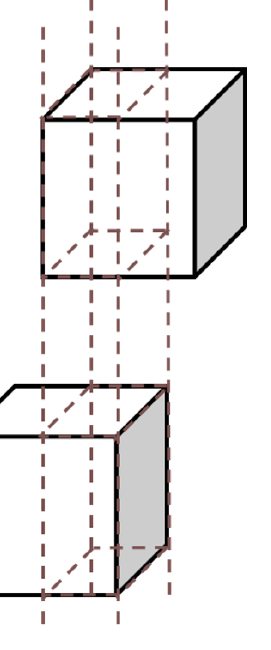
Figure 3. Split the volume along z -axis.